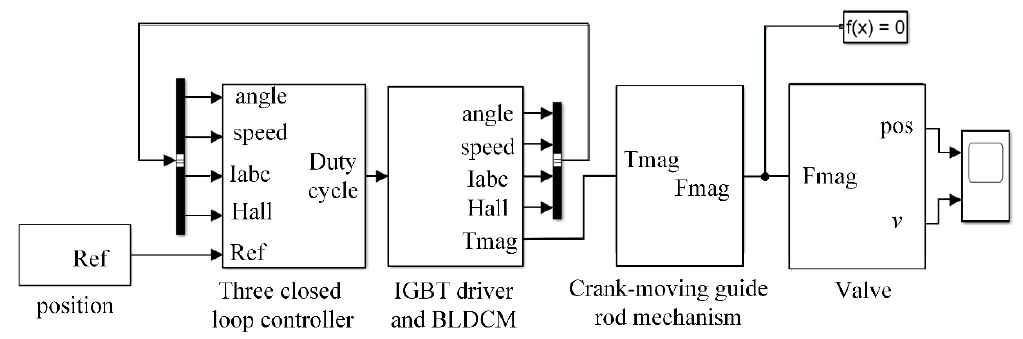
Figure 11. MATLAB / Simulink model of the FVVA system. Figure 11. MATLAB/Simulink model of the FVVA system.